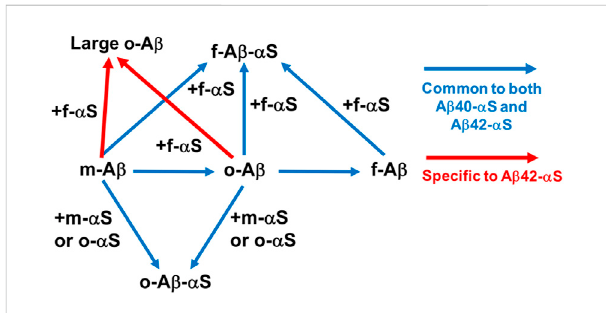
FIGURE 2 DirectA β - α Sinteractionnetworks.Bluearrows:commontoboth A β 40- α S and A β 42- α S (Candreva et al., 2020; Chau and Kim, 2022). Addition of α S monomers and oligomers inhibits fi brilization of monomeric (m-) and oligomeric (o-) A β , while promoting oligomerization of A β monomers and stabilizing preformed A β oligomers via co-assembly.Monomeric,oligomeric,and fi brillar(f-)A β can be incorporated into α S fi brils. Red arrows: speci fi c to A β 42- α S (Chau and Kim, 2022). α S fi brils partially interferes with conversion of solubleA β 42,butnotA β 40,intoinsolubleaggregates, insteadpossibly promoting the formation of large oligomeric A β